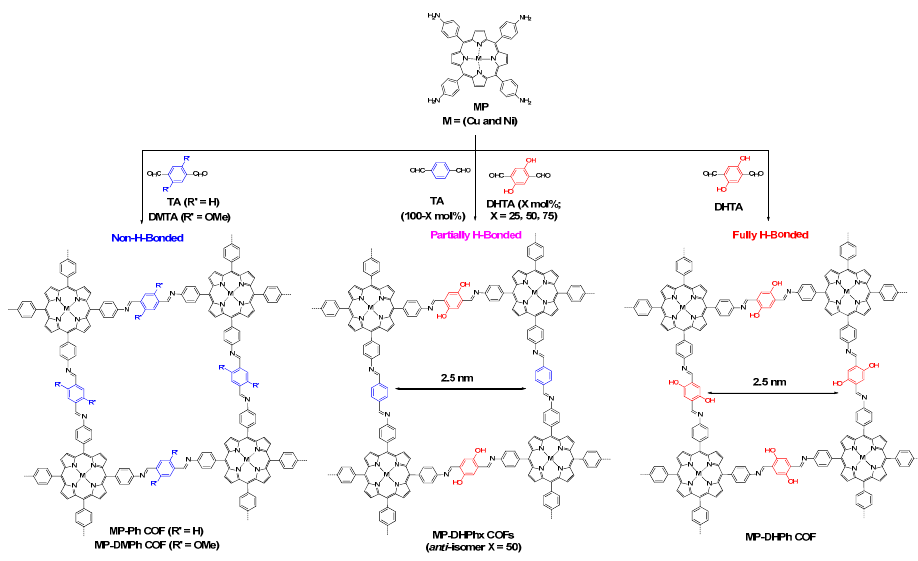
Figure 12. Schematic of the synthesis of 2D porphyrin COFs with designable content of hydrogen- Figure bonding structures.